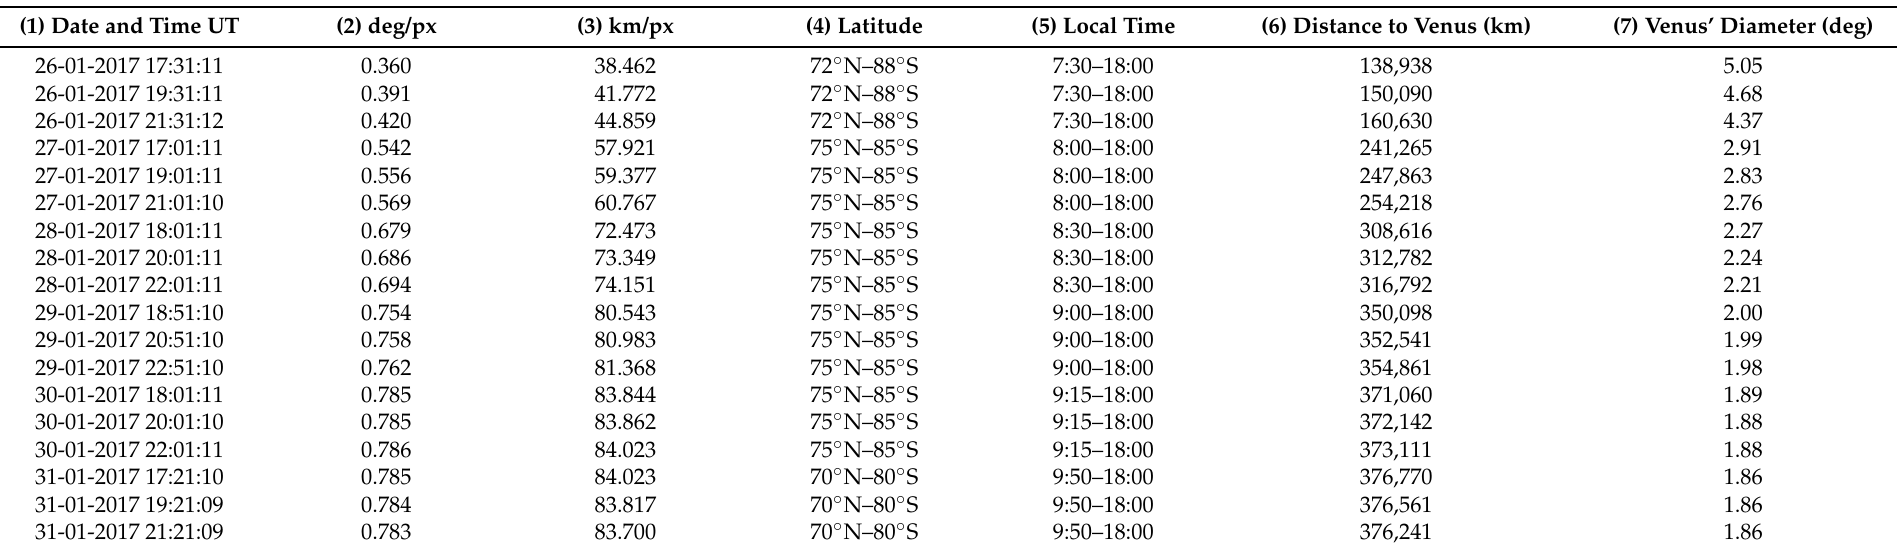
Table 3. Image list from Akatsuki observations, from 26–31 January 2017, of Venus with the 283 nm Ultraviolet Imager (UVI) filter: (1) date and time in UTC; (2) mean resolution in deg/px; (3) mean resolution in km/px; (4) latitude range of Venus’ visible disk; (5) local time range of Venus’ visible dayside; (6) distance between VCO and Venus in km; (7) Venus’ apparent angular diameter in